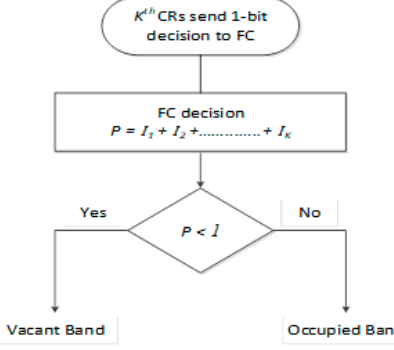
Figure 3. Flow chart of the cooperative spectrum sensing (CSS) proposed scheme.